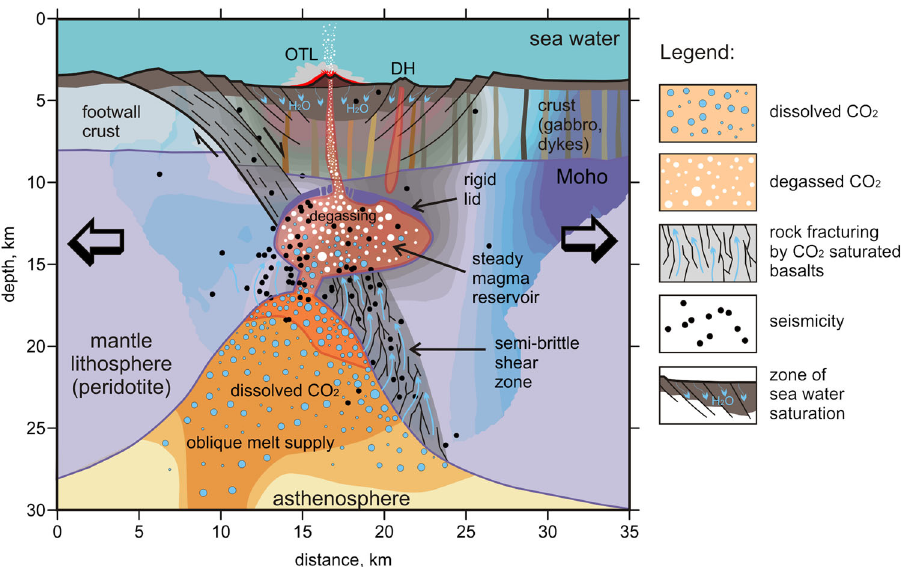
Fig. 4 Interpretation of the resulting Vp/Vs ratios along a section that is oriented across the rift valley (vertical Section 2 in Fig. 2) by considering the numerical modeling results (Fig. 3d, e). The black dots depict earthquakes. See details in the